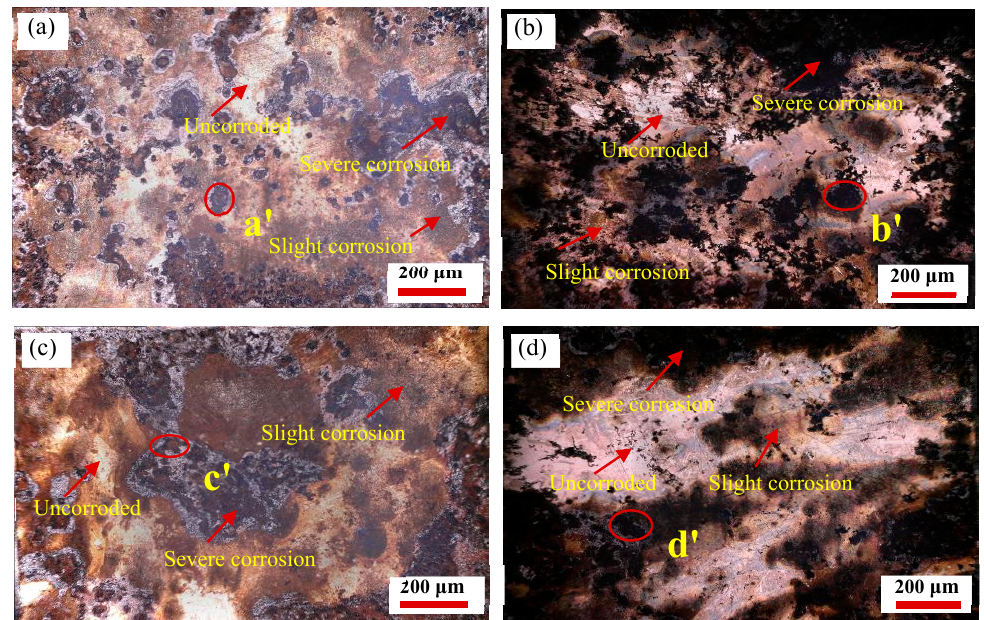
Figure 10. Corrosion morphology of the 35CrMoV steel: ( a ) 0.01 s − 1 , 850 °C; ( b ) 0.01 s − 1 , 1050 °C; ( c ) 10 s − 1 , 850 °C; ( d ) 10 s − 1 , 1050 °C.